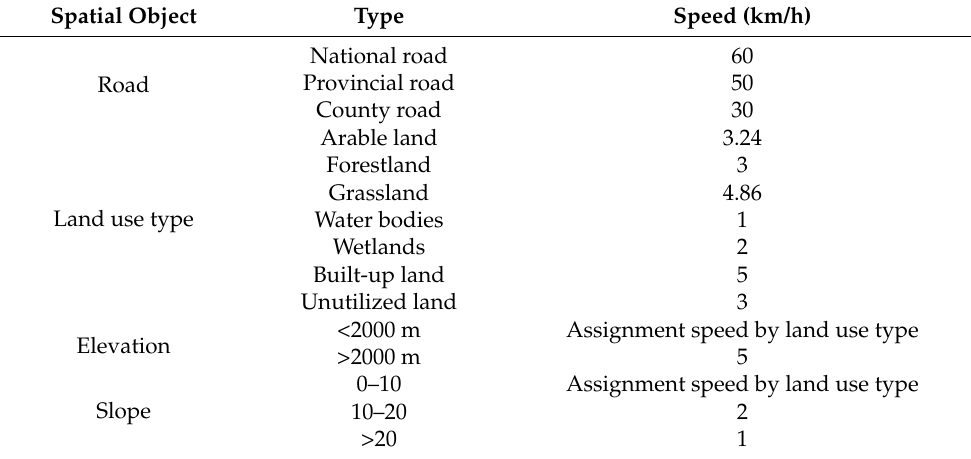
Table 1. Assignment of velocities to different surface grids in the YGGRD. Spatial